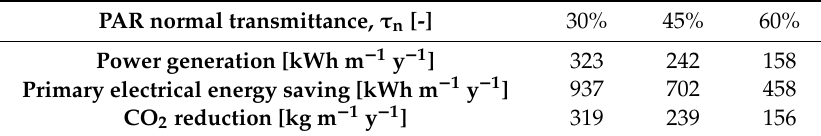
Table 11. Yearly power production per greenhouse length